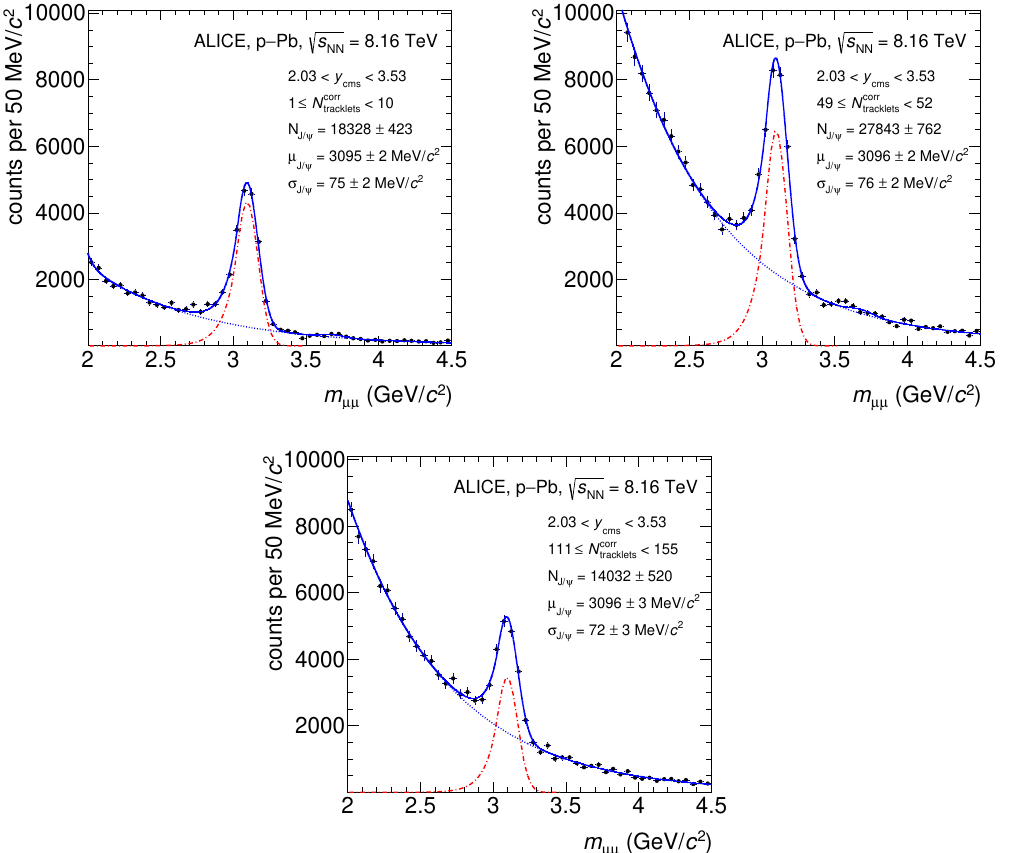
Figure 1 . Opposite-sign muon pair invariant mass distributions for selected multiplicity intervals, corrected for the J = acceptance and e(cid:14)ciency, at forward rapidity. The distributions are shown together with a typical (cid:12)t function (solid line, see text for details). The J = signal contribution is also depicted by a dot-dashed red line, and the background by a dotted